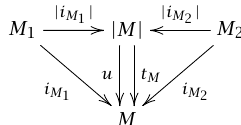
Figure 3.1 . Coproduct of free objects is free.